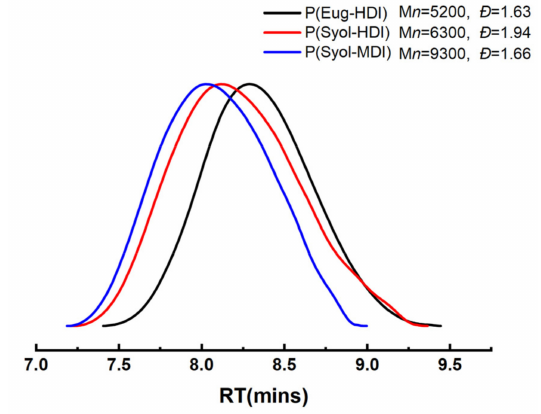
Figure 5. GPC curves of polymerization products.